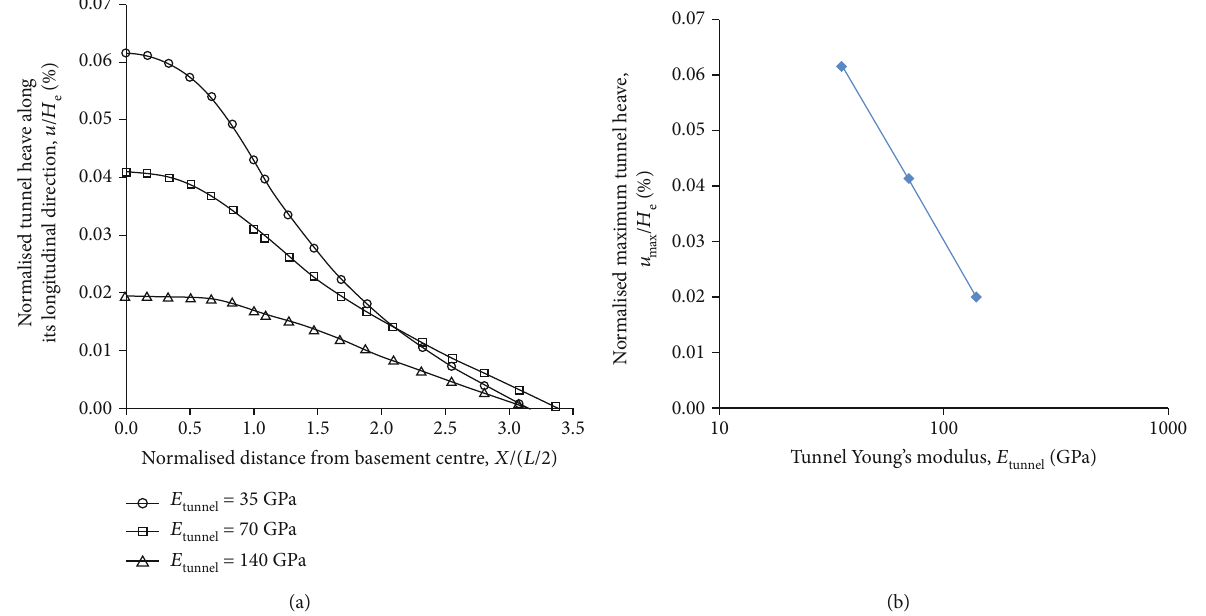
Figure 7: In fl uence of tunnel Young ’ s modulus on (a) tunnel heave along its axis and (b) maximum tunnel displacement in clay.